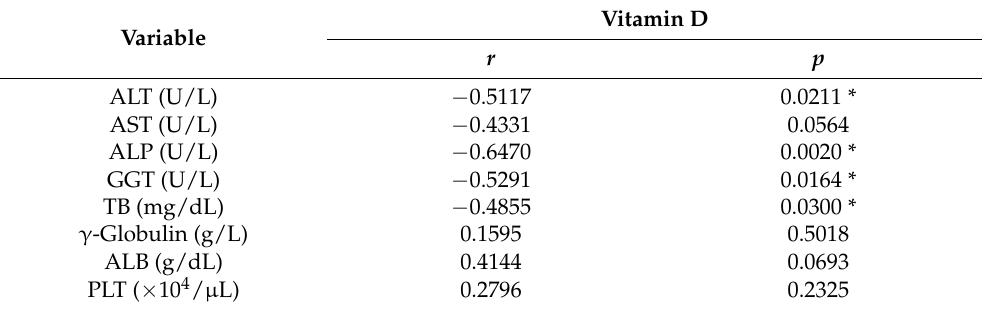
Figure 1. Baseline characteristics of patients. ( a ) Schematic representation for data collection (healthy controls in blue and patients with AIH in red). ( b ) Age in all patients included in the study. ( c ) Vitamin D in serum. Each dot represents measurements from one patient; unpaired t -test with data presented as the mean with SEM, p < 0.0001 (****). Table 2. Relationship between vitamin D and laboratory parameters in patients with AIH.